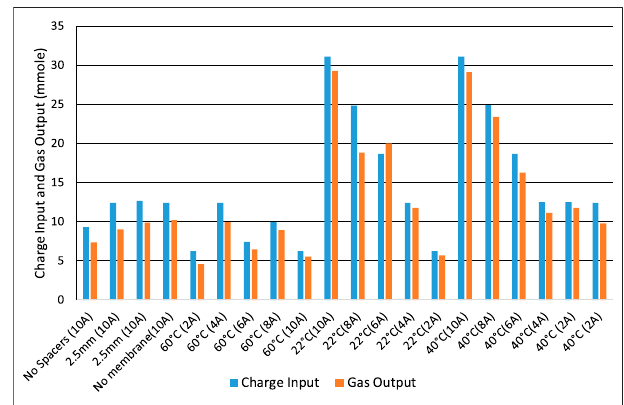
FIGURE 9 | Electrolysis tests starting with a fully charged cell. Charge input and equivalent gas output in terms of effective charge used and at different charge rates.